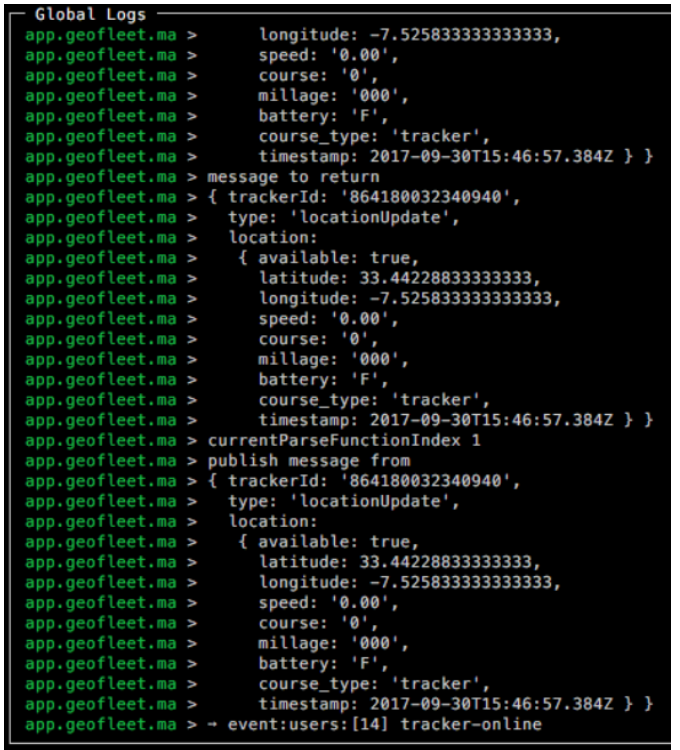
Figure 18. Real-time reports. A dashboard screenshot showing the available real-time reports where the main reported information can be